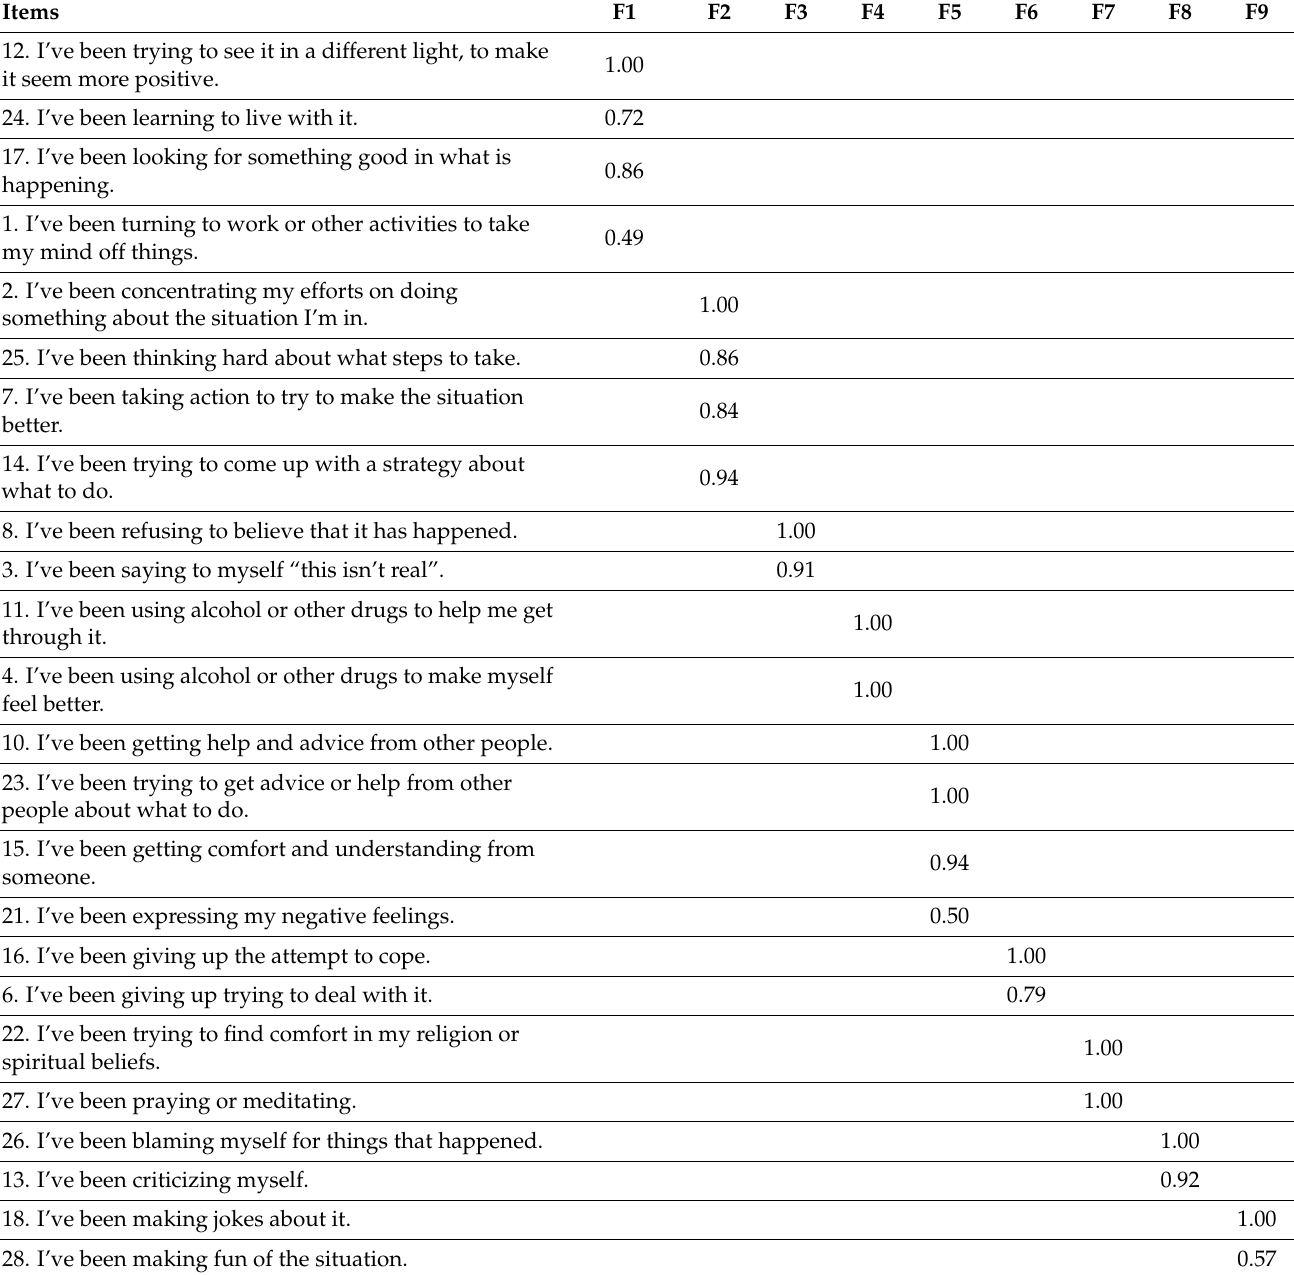
Table 4. French revised scale reliability: omega loadings of total